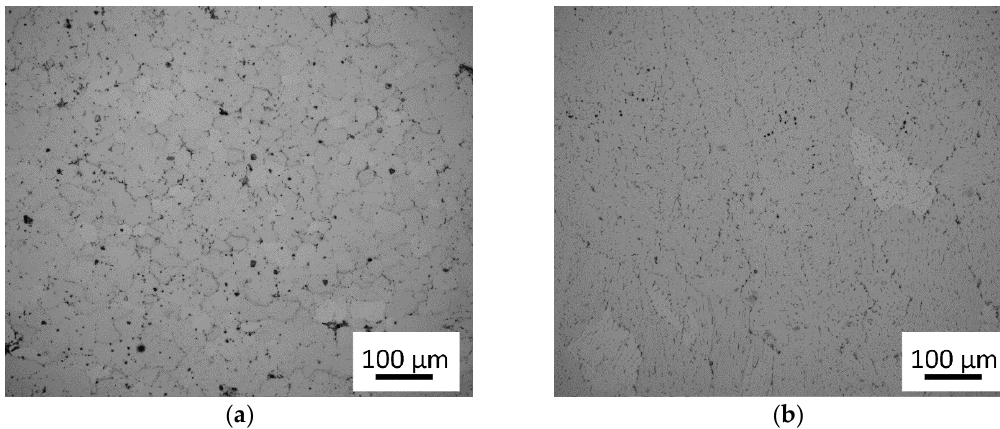
Figure 9. Details of particles distribution in Al-Li-Cu-Mg-Zr-Sc ( a ) and Al-Li-Cu-Mg-Zr ( b ) alloys after linear heating up to 500 °C and further artificial aging 500 °C/80 min.